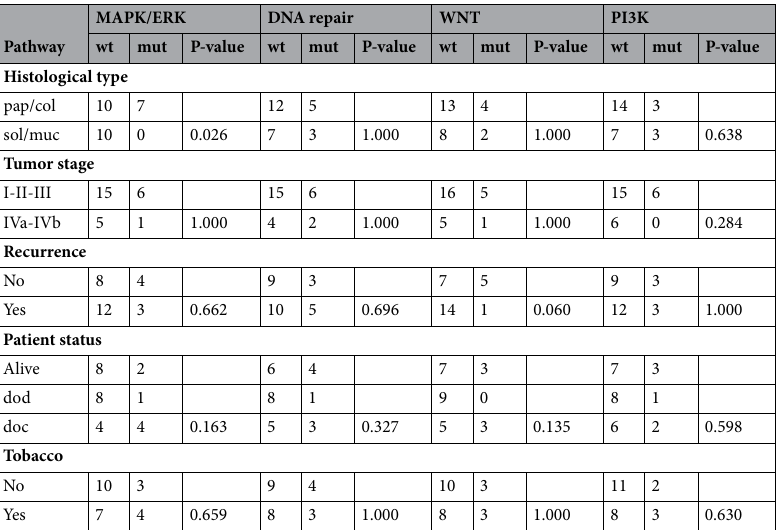
Table 2. Correlation between mutated pathways and clinical characteristics. MAPK/ERK pathway genes include NF1, KRAS, BRAF and MAP2K1; DNA repair pathway genes include ATM, BRCA1, BRCA2 and DNMT3A; WNT pathway genes include APC and CTNNB1; PI3K pathway genes include PI3K, PIK3R2, AKT, MTOR; pap/col: papillary and colonic type ITAC; sol/muc: solid and mucinous type ITAC, DOD: died of disease, DOC: died of other